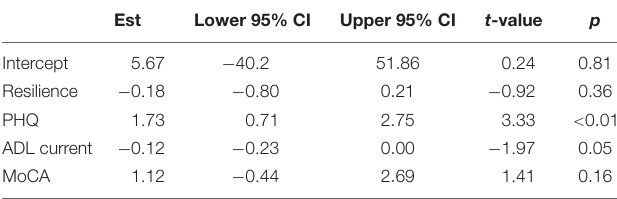
TABLE 3 | Predictors of health-related Calman